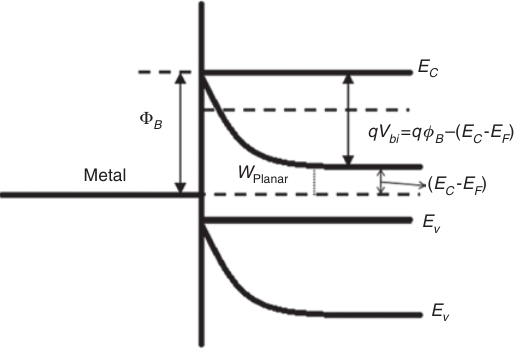
Figure 1: A schematic of a planar M-S contact at the equilibrium state.